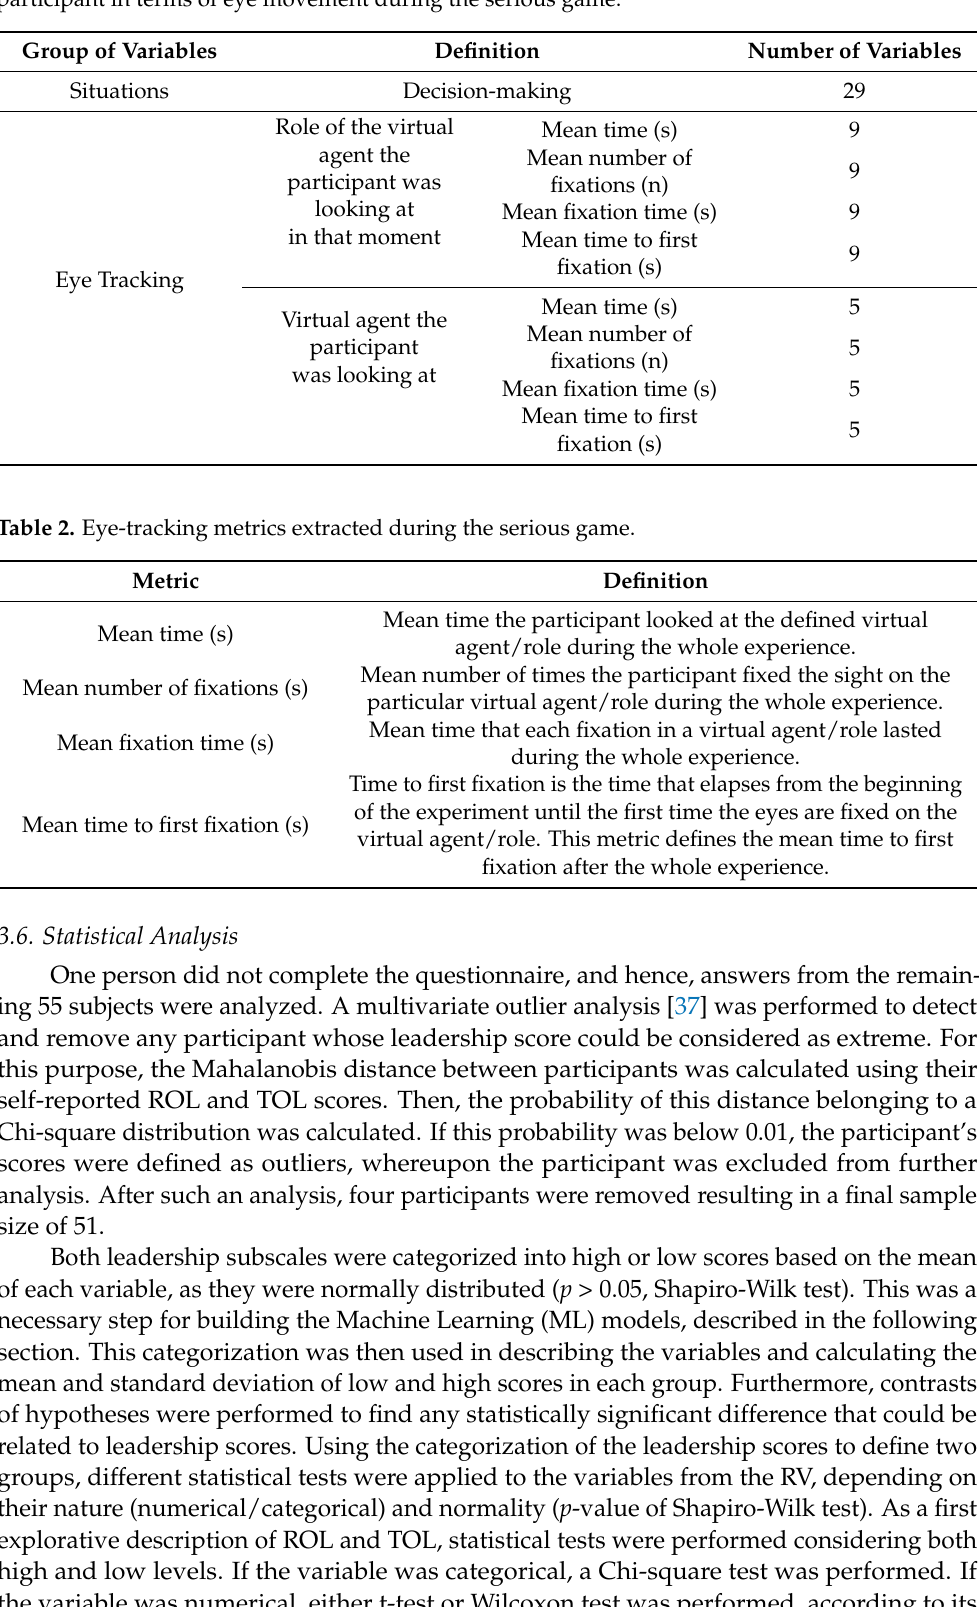
Table 1. Description of the variables extracted from the decisions made and the behavior of the participant in terms of eye movement during the serious game.